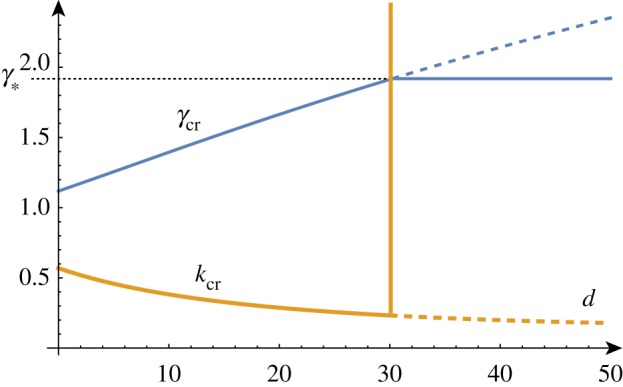
kcr and γcr as functions of d for β = 10. (Online version in colour.)